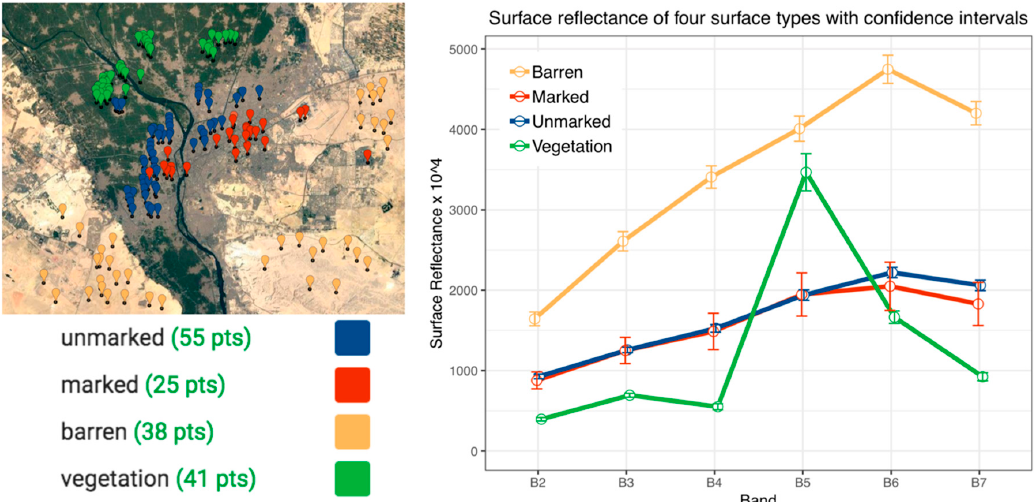
Figure 8. The surface reflectance for four types of land-cover surfaces with confidence intervals in the Cairo and adjacent region, including human habitats not marked as high impervious surface (Unmarked Habitat), human habitats marked as high impervious surface (Marked Habitat), barren areas with human habitats and vegetation (Barren) and vegetation areas such as croplands or grasslands (Vegetation).